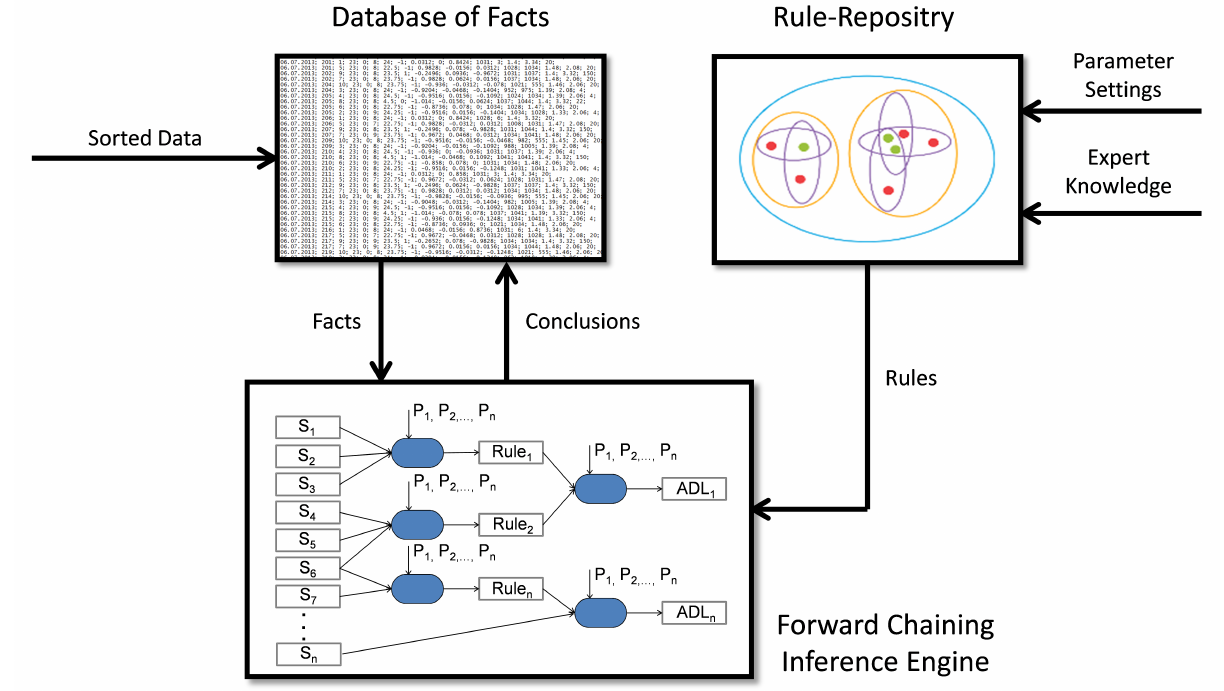
Figure 5. Block diagram of the ADL classifier algorithm based on a forward chaining inference engine.